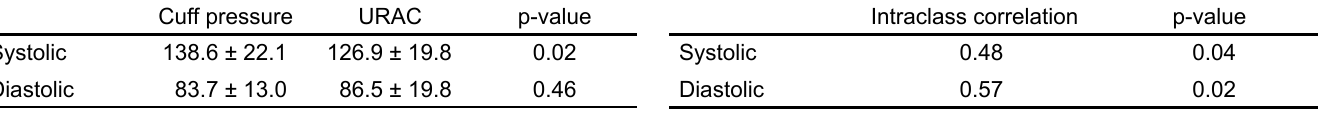
Table 1. Comparison of mean automated cuff pressure versus mean ultrasound-guided radial compression (URAC) pressure and corresponding p-values.